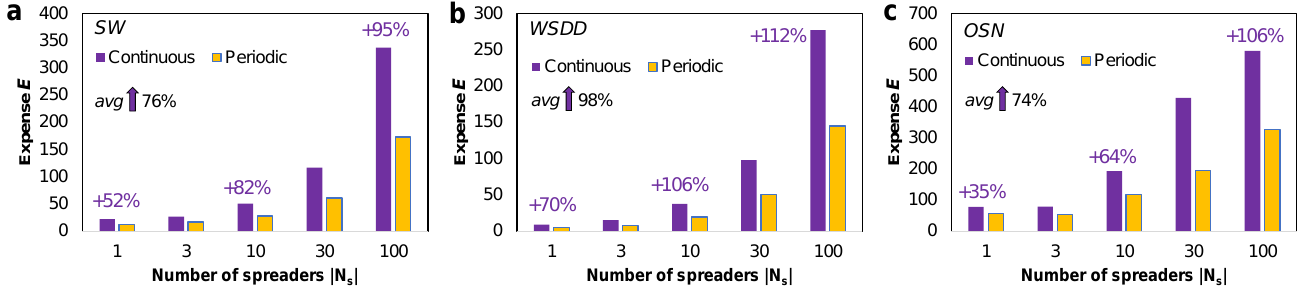
Figure 2. Comparison between the continuous (violet) and periodic (yellow) injection strategies, in terms of the indoctrination expense E , on three representative networks, one from each category (see Table 1): ( a ) small-world SW ; ( b ) Watts–Strogatz with degree distribution WSDD ; ( c ) online social network OSN . The violet text represents the increase in expense E of the continuous strategy, namely the difference between the violet column and the adjacent yellow column. Measurements of E focus on the increase in the number of spreaders | N s |